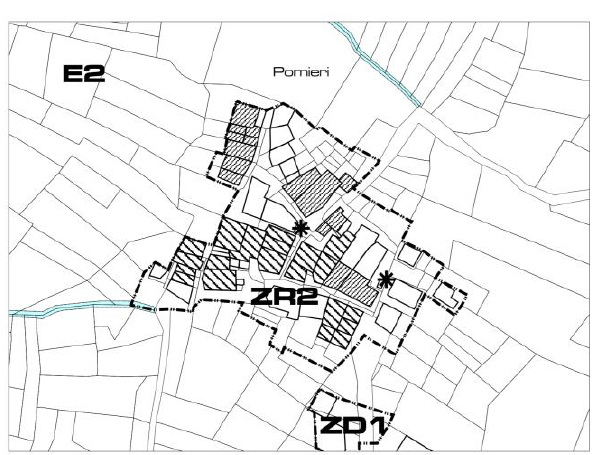
Figure 8. Recovery and developments area of Pomieri (scale 1:1000), ZR2 express Recovery areas and ZD1, development zone, * are fountains or ovens. Buildings on the north need philological restoration, and buildings in the south of the hamlet need conservative renovation activities. Figure 5. Concepts, relations and properties from the 3) The document “Schede e Tabelle di Zona”, Zone “Relazione, tav 7.11”. Cards and Tables, (Comunità Montana Del